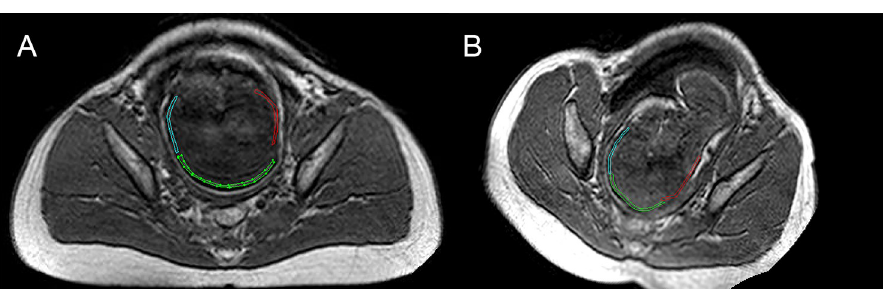
Fig 2. MRI measurement of fetal head molding in patient 1. (a) Axial MRI before entering labor. Finite element splines of the occipital bone (red) and frontal bone (blue) are shown to be continuous with the parietal bone (green). The appearance of the fetal skull is normal. (b) Axial MRI during the second stage of labor. The fetal head is located at the middle of the pelvic brim. The lambdoid fontanelle (seen between the green and red lines) is closed. The parietal bone (green) is shown to slightly overlap the occipital bone (red). There is also slight overlap of the frontal bone (blue) over the parietal bone (green). A characteristic "sugarloaf" deformation of the fetal head was observed on MRI. Similar findings were observed in all fetuses. Suture overlapping was greater in the anterior-posterior direction, especially at the coronal and lambdoid suture, and less important at the sagittal and metopic sutures (Table 1). The head of this fetus kept the “sugar loaf” shape after